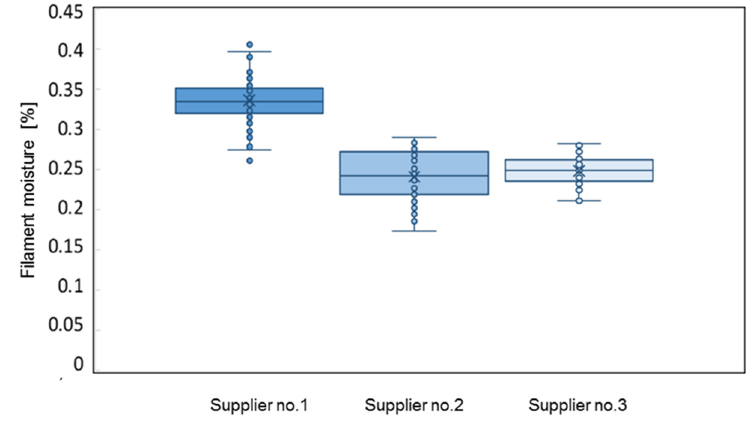
Figure 4. Moisture contents of filaments provided by various suppliers.